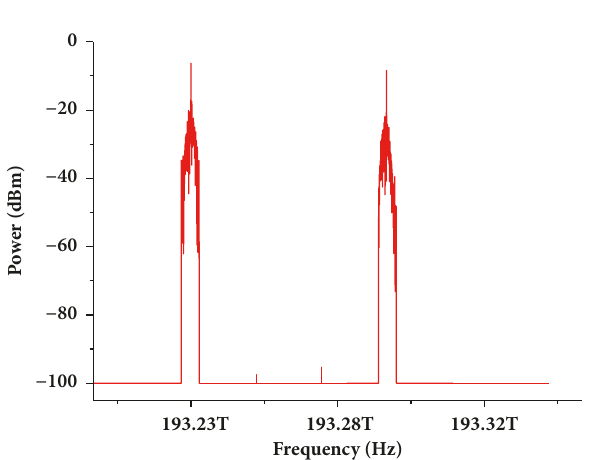
Figure 9: Electrical spectrum of 20GHz mm-wave.